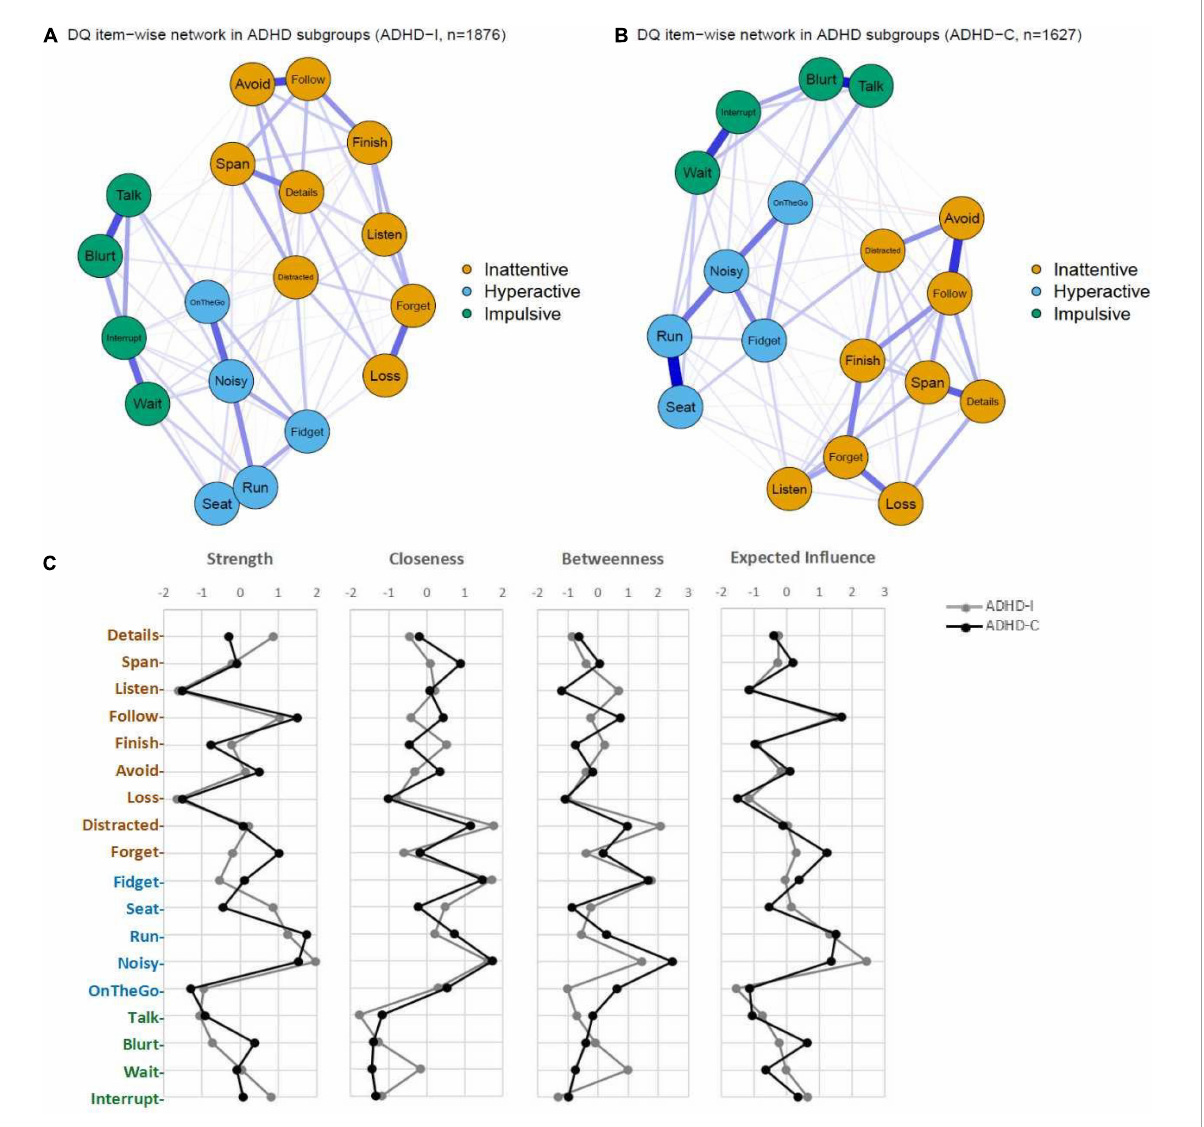
FIGURE3 The network structures in different subtypes. (A) network in ADHD-inattentive subtype (ADHD-I); (B) network in ADHD-combined subtype (ADHD-C); (C) centrality indices and Expected Influence of the symptom networks in ADHD-I and